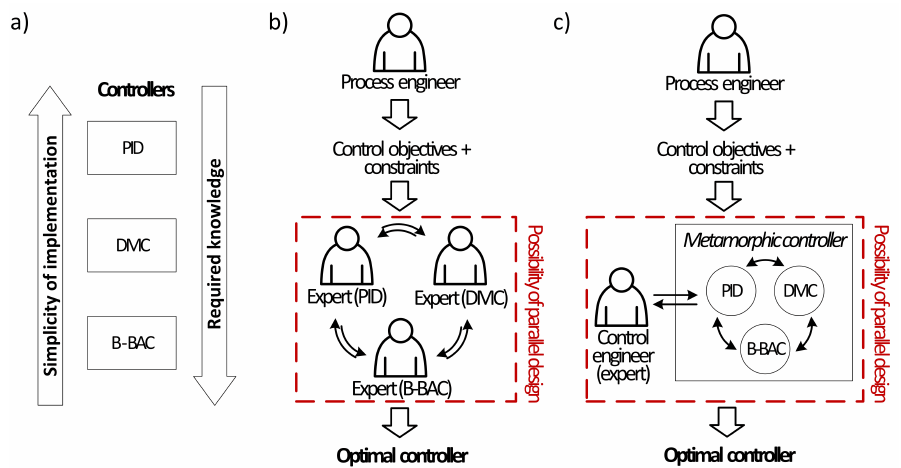
Figure 1: The selection of the controller structure and its parameterization at the controller design stage: a) comparison of the available controllers; b) selection of the optimal controller by cooperation of experts; c) metamorphic controller as a tool for selection of the optimal controller